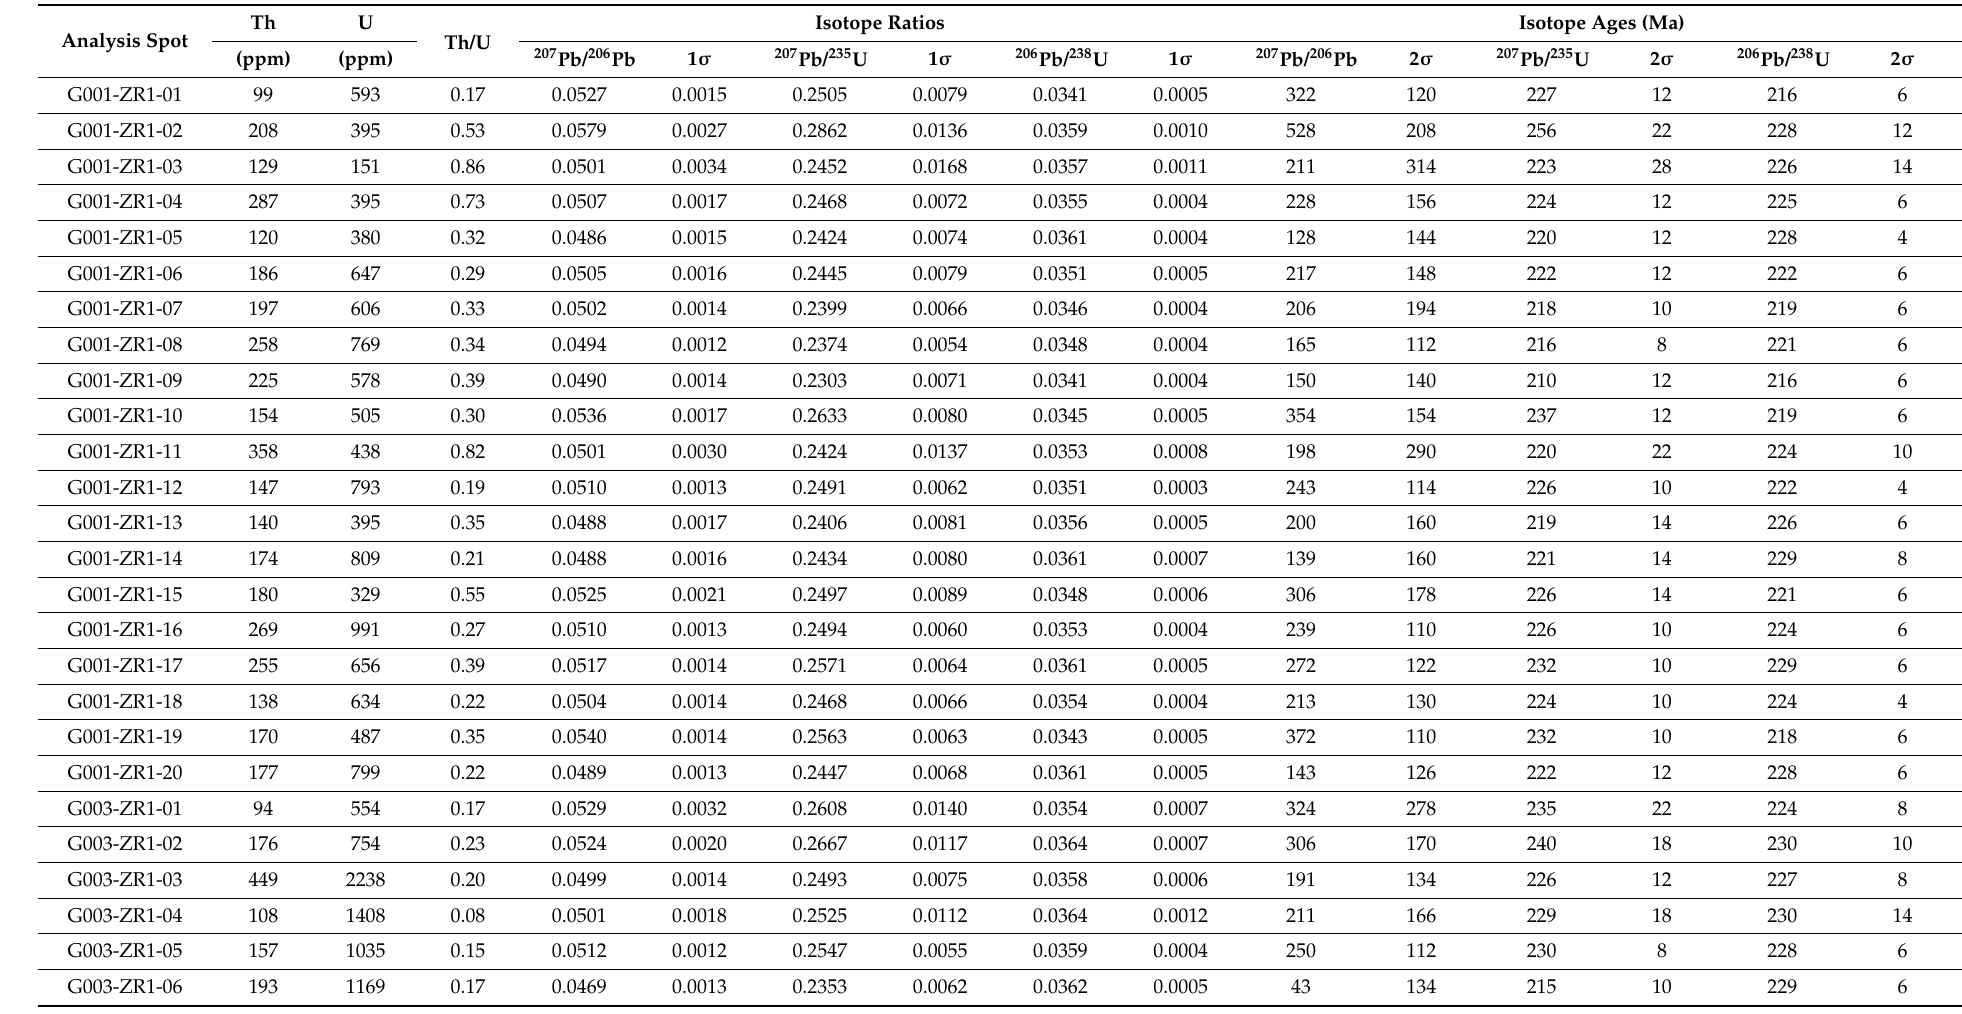
Table 1. LA-ICP-MS zircon U-Pb dating data of Baishi